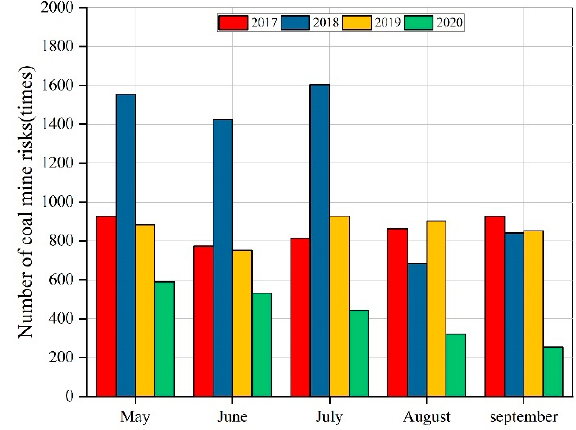
Figure 16. Comparative analysis of the number of risks.